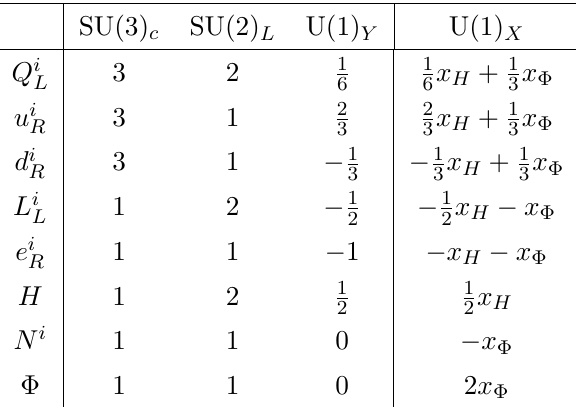
Table 1 . Field content and charge assignments in the non-exotic U(1) X model. i = 1 , 2 , 3 is generation index. 1 x H and 2 x Φ are the U(1) X charges assigned for the SM Higgs boson H and the 2 new Higgs boson Φ , with x H and x Φ parameterizing the U(1) X charges of the fields in the